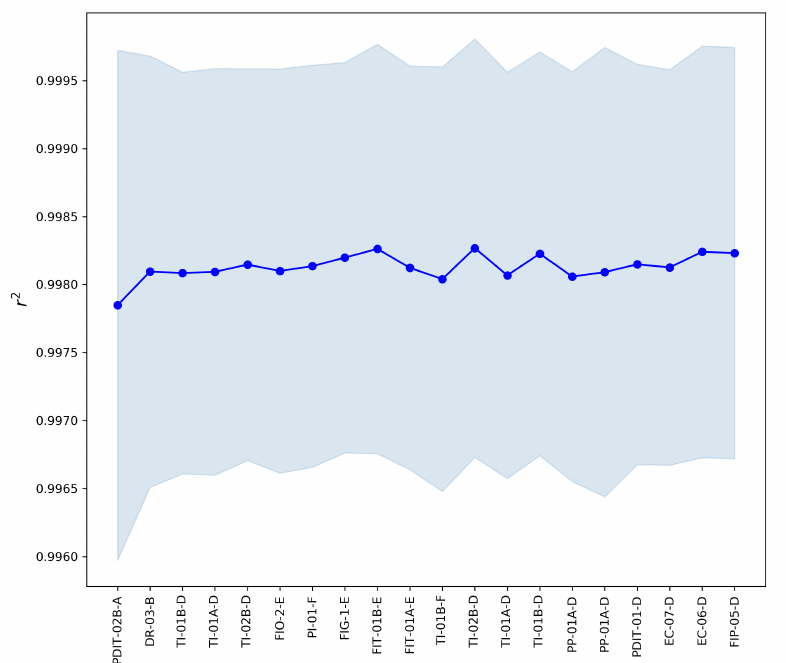
Figure A10. Variables subset for Fault F-I detection selected by the forward feature elimination (Lasso)